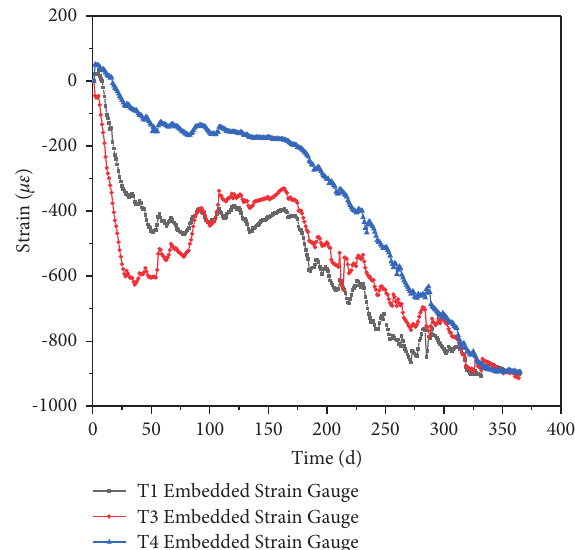
Figure 16: Internal shrinkage strain curves of T1, T3, and T4 specimens with